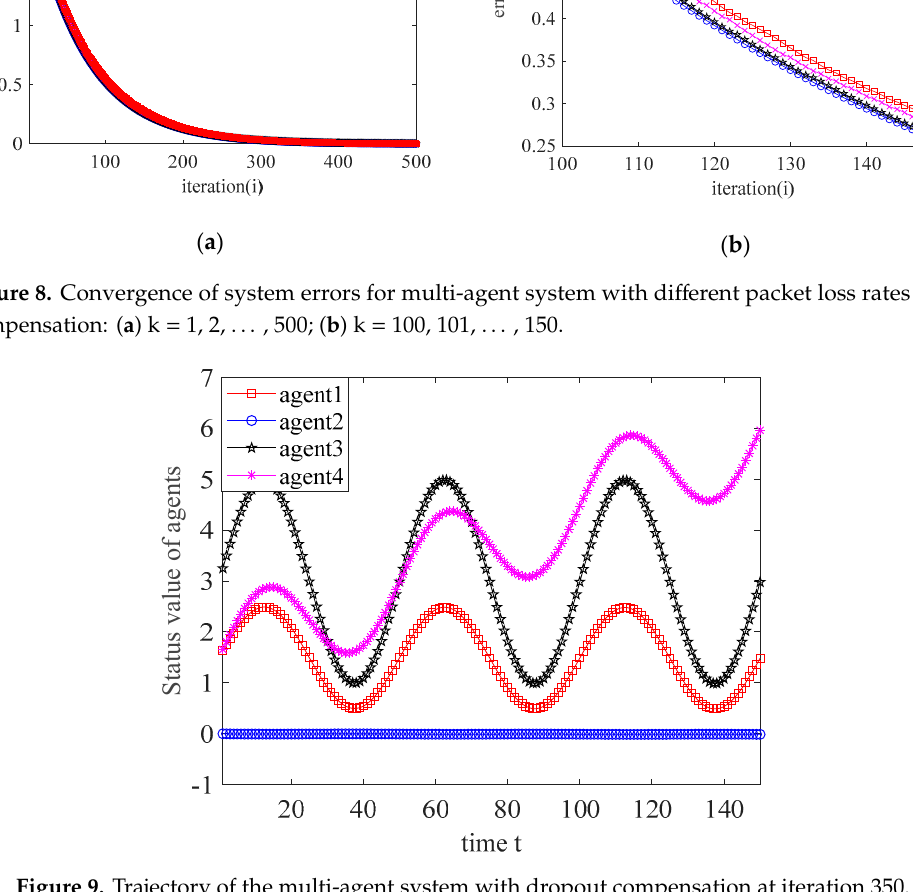
Figure 9. Trajectory of the multi-agent system with dropout compensation at iteration 350.